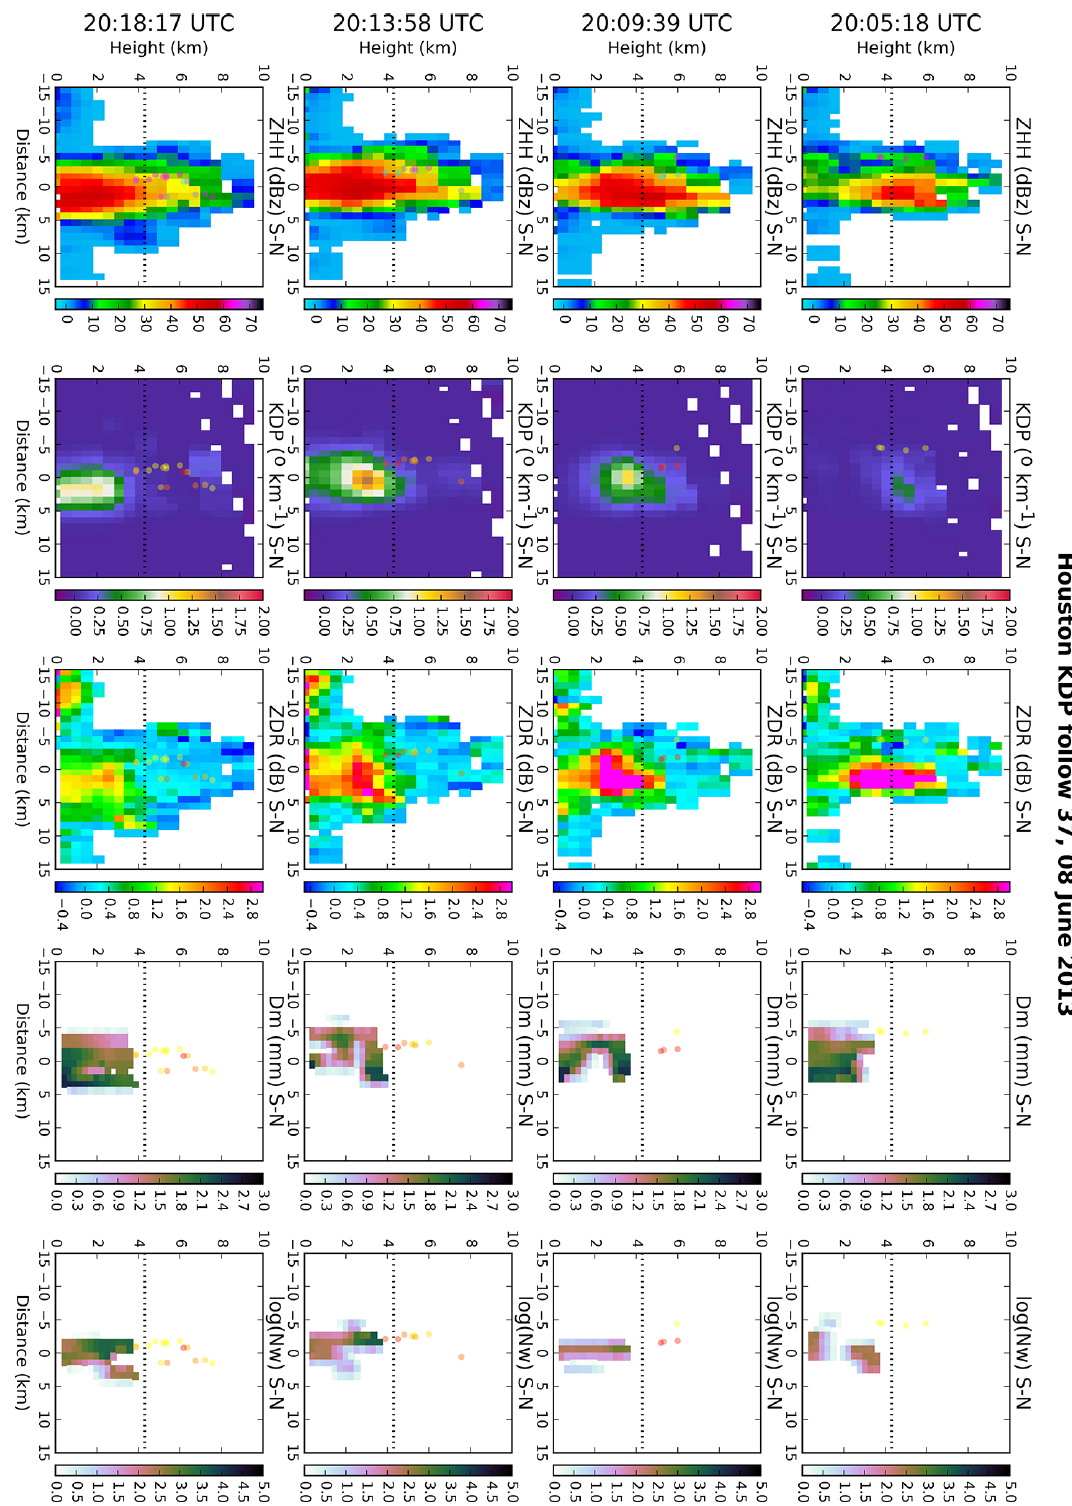
Figure 6. As in Fig. 5 except for observed K DP column